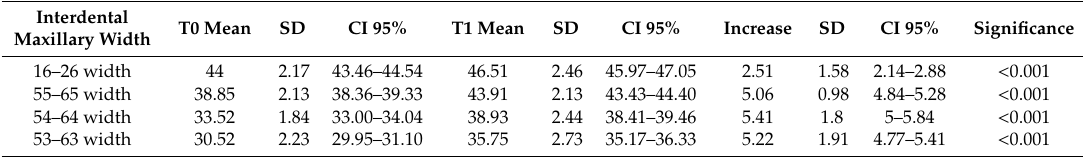
Table 2. Paired t -test comparing the mean interdental maxillary width (mm) increase after SME treatment—Test Group (n ◦ 69).